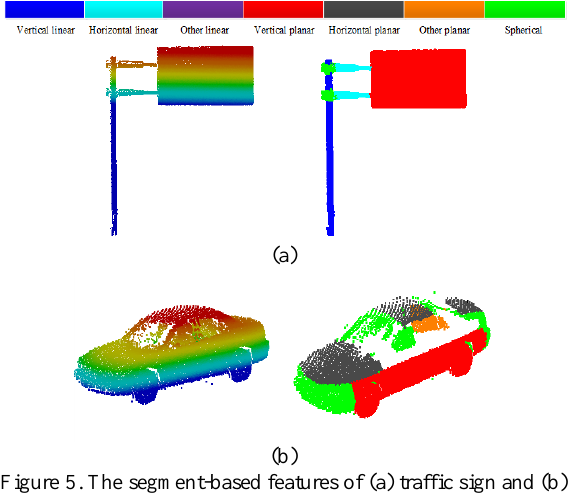
Figure 5. The segment-based features of (a) traffic sign and (b) car.